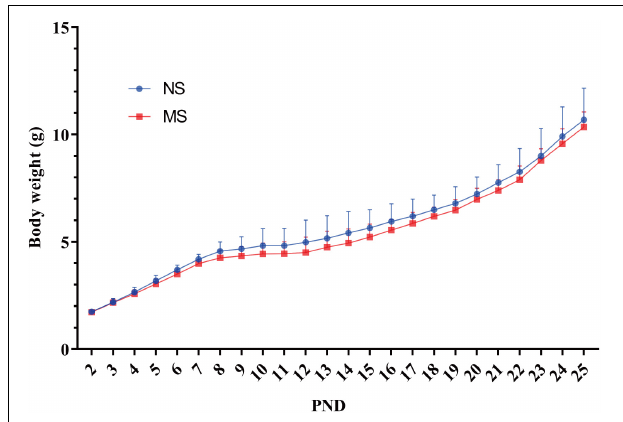
FIGURE 4 | Comparison of mice body weight between MS and NS. There was no significant difference of mice body weight between MS and NS. NS, non-separation; MS, maternal separation; PND, postnatal day. MS, n = 12, NS, n = 10.